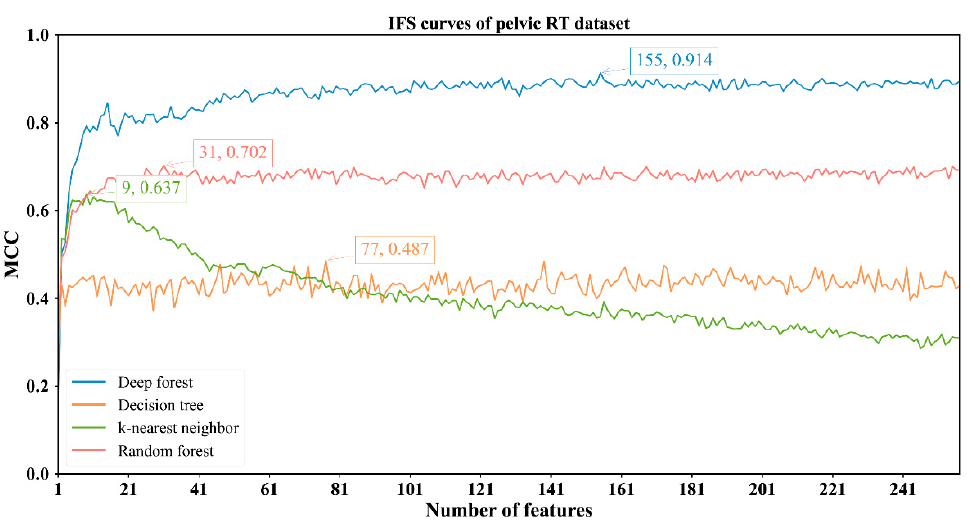
Figure 5. IFS curves with different classifiers on the different numbers of methylation features for pelvic RT methylation dataset. DF yields the highest MCC value of 0.914 when the top 155 features are employed.